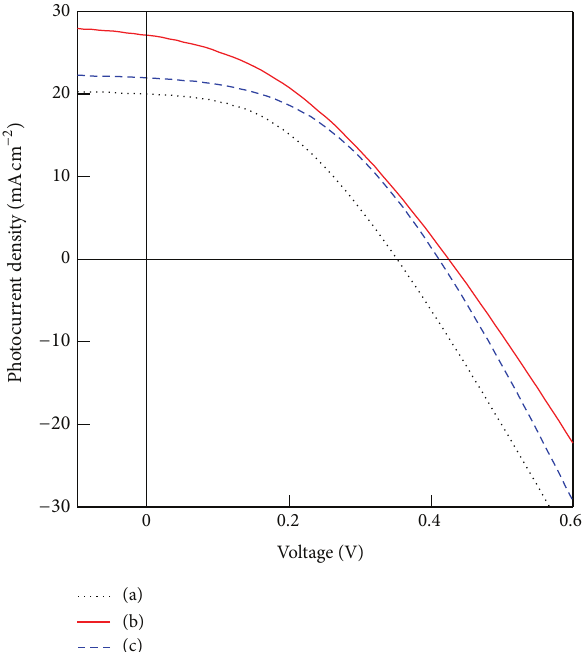
Figure 5: Photocurrent density-voltage curves of CIGS solar cells with KCN etching before annealing (a), after annealing (b), and without KCN etching (c); all samples annealed at 540 ∘ C for 30min under selenium vapor ambience.